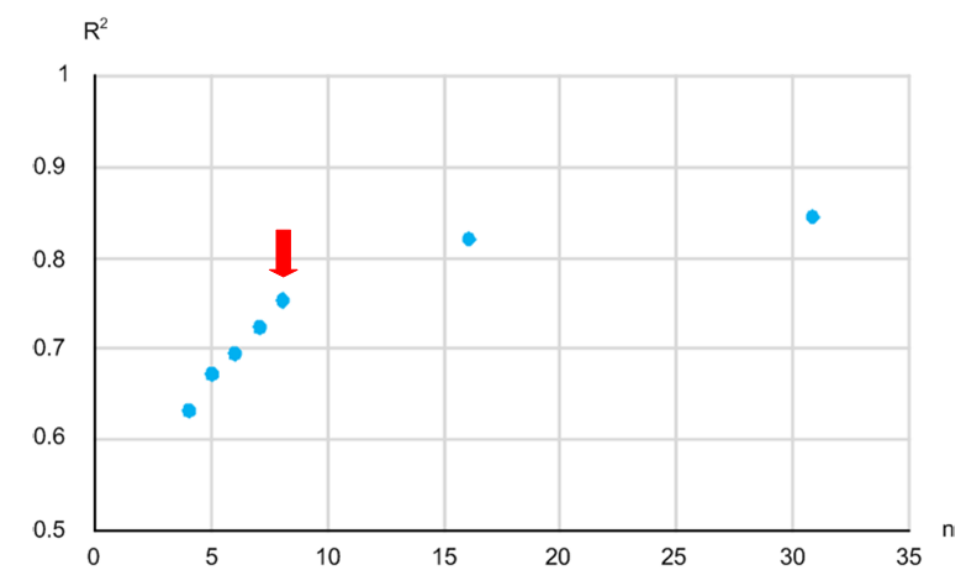
Figure 6. Relationship between the R 2 and the number ( n ) of wavelengths.